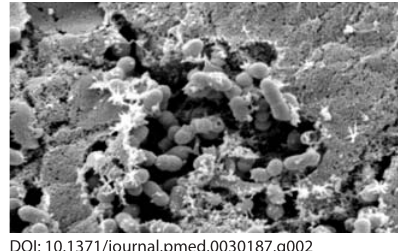
Figure 1. Scanning Electron Microscopy of S. suis Diplococci in a Sheet of Mucus on